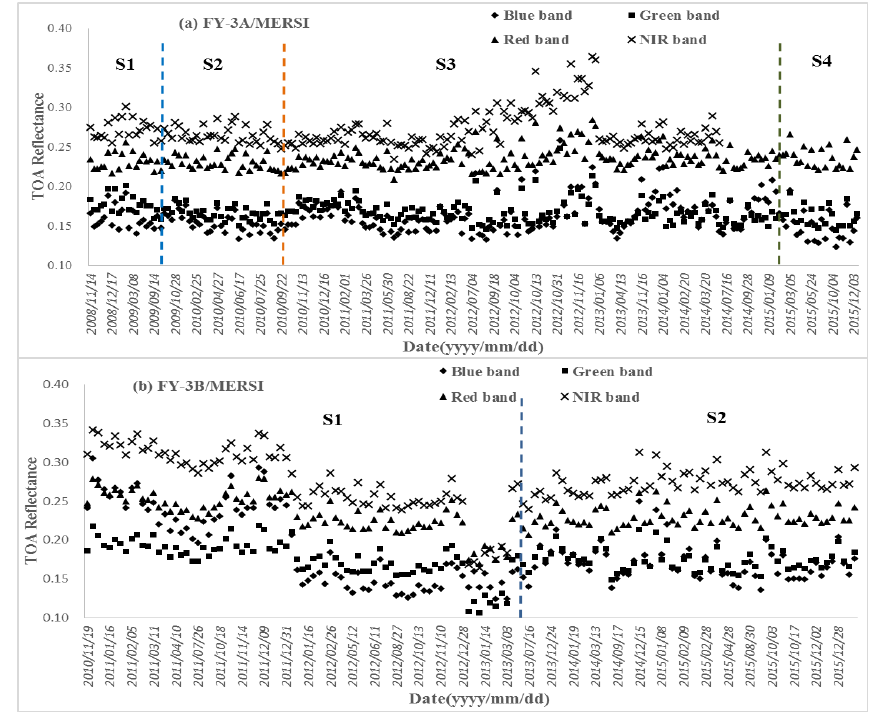
Figure 9. Time series of TOA reflectance of MERSIs in reflective bands: ( a ) FY-3A/MERSI from 2008 to 2015; ( b ) FY-3B/MERSI from 2010 to 2015. Table 12. The statistics from the time series of the TOA reflectance of FY-3/MERSIs.